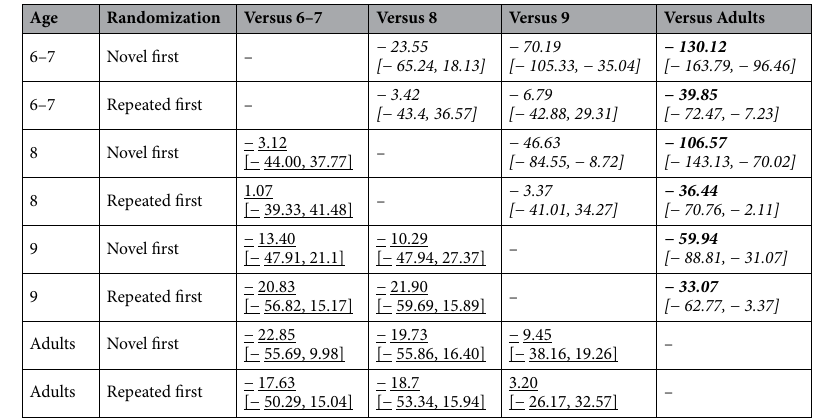
Table 4. Group differences in distraction effects in the block effect model as a function of block and randomization. The values represent differences in distraction effects (i.e., differences between the groups in (cid:31) RT (cid:31) RT the quantity distractor − standard ). The upper triangle (italic) displays the differences between groups in the first block of the experiment. Substantial differences between children and adults are marked in bold italic (CIs did not cross zero). The lower triangle (underline) displays the differences in last block of the experiment. 95% confidence intervals are given in square brackets. A negative value indicates a smaller distraction effect in the group indicated by the column than in the group indicated by the row.